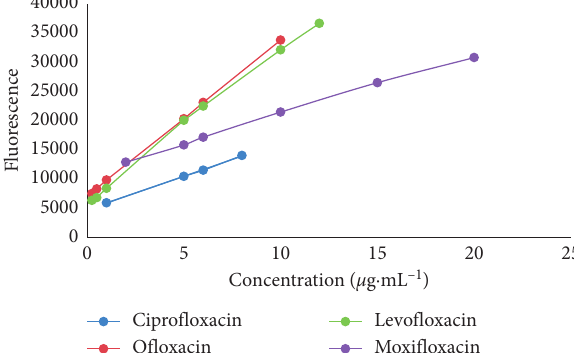
Figure 5: Fluorescence intensity vs. time: (a) ciprofloxacin, condition: flow rate: 400 μ L · min − 1 , integration time: 600mS, λ concentration range: 0.5–25 μ g · mL − 1 ; (b) moxifloxacin, condition: flow rate: 400 μ L · min − 1 , integration time: 600mS, λ max : 512nm, and concentration range: 0.5–40 μ g · mL − 1 .